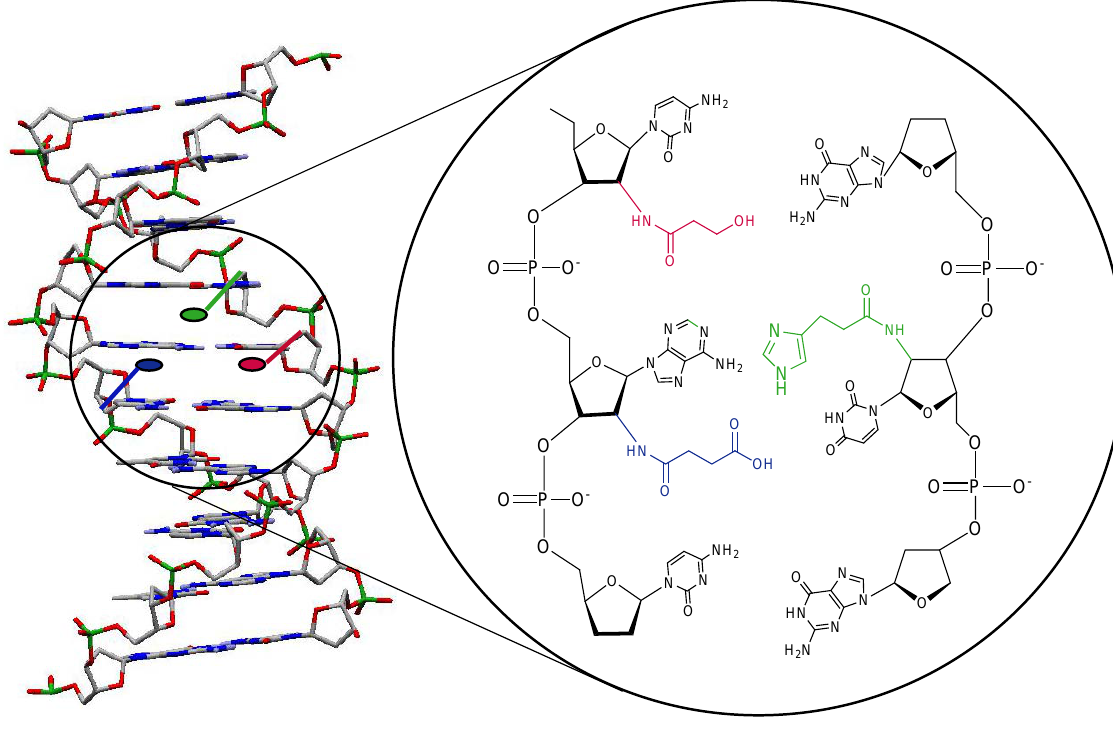
Figure 2 : Creation of an active site.